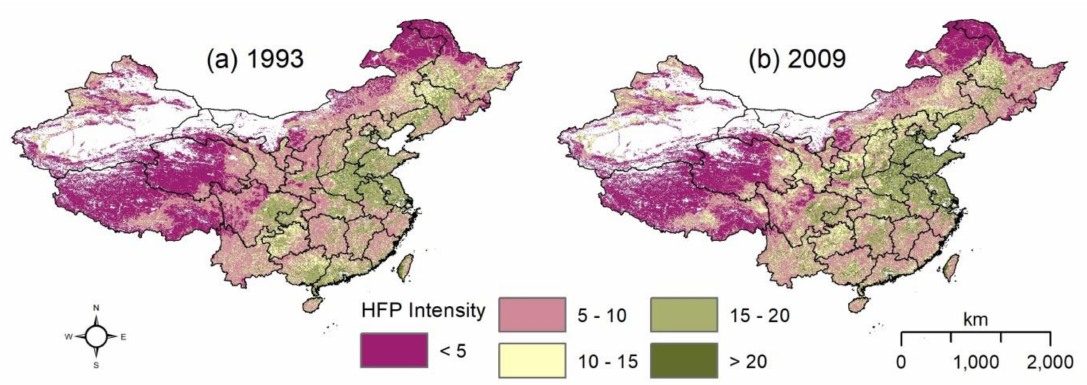
Figure 2. Human footprint intensity (HFP): ( a , b ) HFP for 1993 and 2009, respectively.